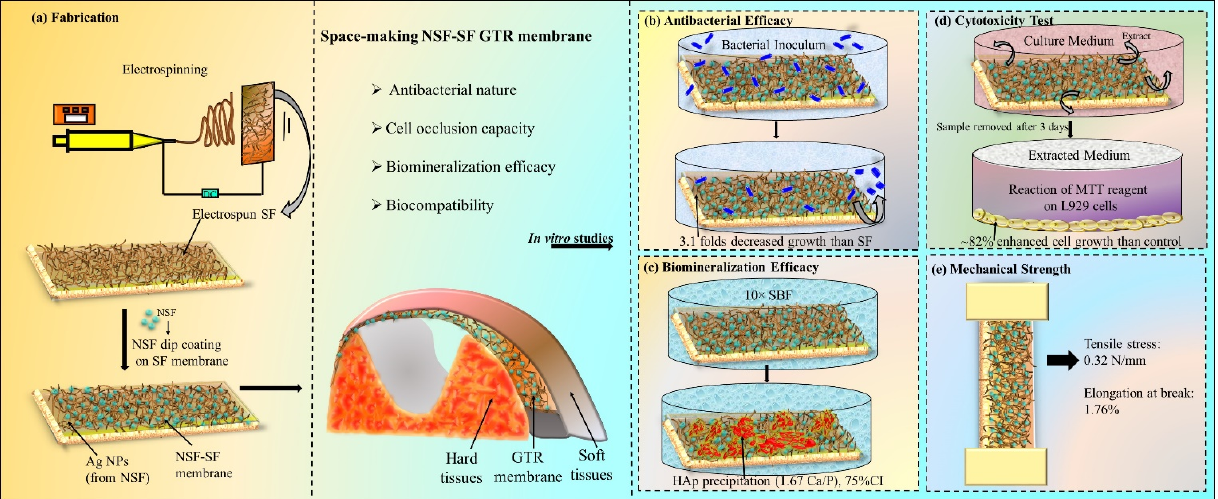
Scheme 1. Representation of the GTR membrane at the affected area, ( a ) its fabrication, in vitro properties studied as ( b ) antibacterial, ( c ) biomineralization, and ( d ) biocompatibility efficacy, and ( e ) mechanical strength test.